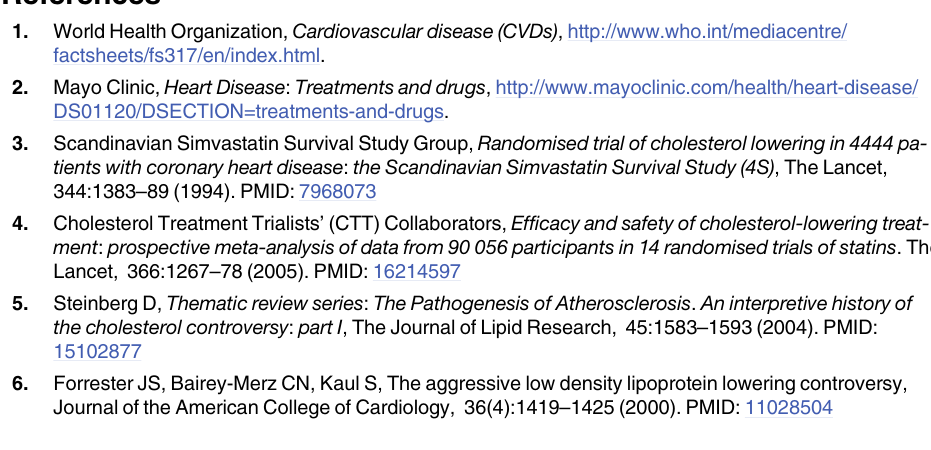
S1 Table. The primary outputs are shown for all cancers in the multivariate models includ- ing aortic or coronary are shown for non-imputed (raw) data by each diagnosis type with a corresponding optimized model (where non-selected co-variates are removed). S2 Table. The primary outputs are shown for all cancers in the multivariate models includ- ing aortic or coronary are shown for imputed data by each diagnosis type with a corre- sponding optimized model (where non-selected co-variates are removed). S3 Table. The summarized odds ratios are shown of all models (output = cancer type) for non-imputed and imputed data for aortic and coronary